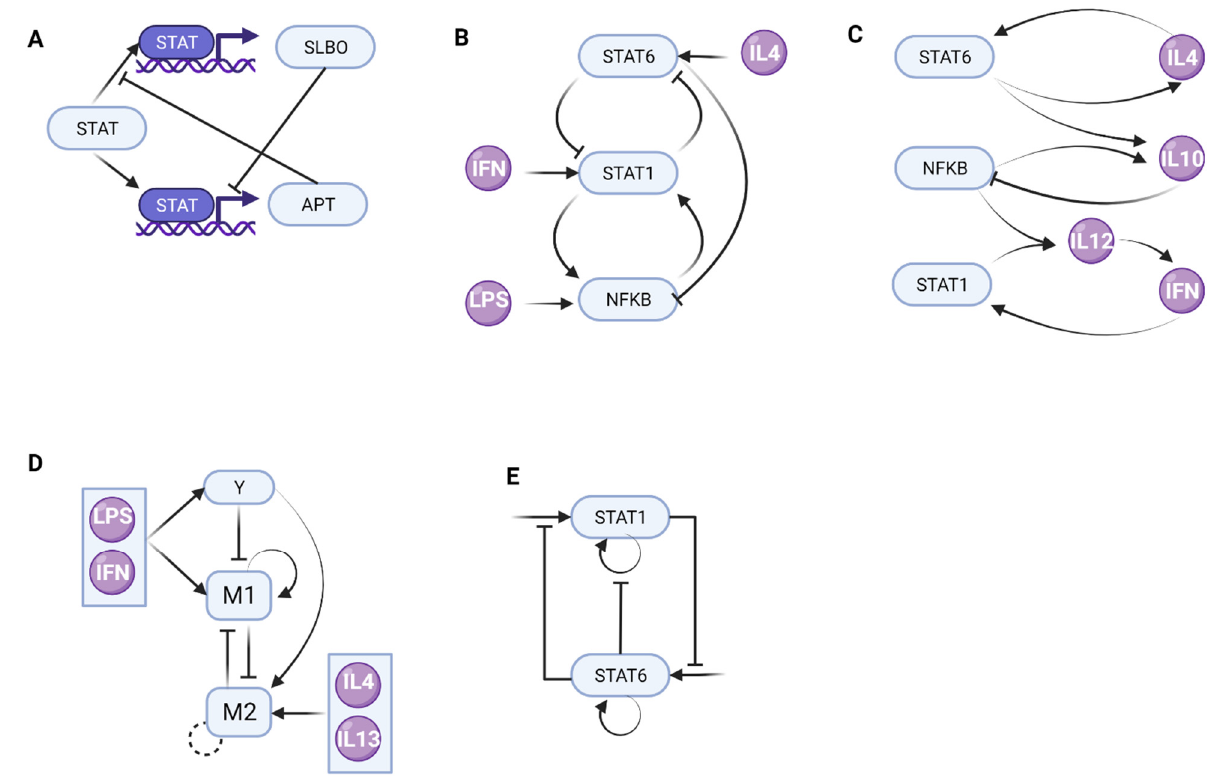
Figure 2. Models showing multistability of signaling pathways involved in macrophage transitions: ( A ) The inhibition of STAT activity by APT and the cross-repression of APT and SLBO conforms to a molecular switch that determines if an epithelial cell becomes motile or remains stationary. ( B ) The mutual inhibition and mutual activation of STAT6, STAT1, and NFKB creates saddle-node bifurcations in macrophage polarization. ( C ) An agent-based model describes macrophage population behavior in the context of cytokine production to influence bistability switches and demonstrates that a dynamic bifurcation is a crucial built-in mechanism of macrophage activation. ( D ) A minimal regulatory model shows that a mutual inhibition motif is not by itself sufficient; an incoherent feedforward mechanism of M1 activation as well as both inhibition and activation of M2 by M1 are required for bistability. Y represents feedback inhibition mechanisms. ( E ) A simple model of macrophage polarization tracking STAT1 and STAT6 activation levels as proxies for M1 and M2 transitions, including self-stimulation and a mutual-inhibition to demonstrate that both external cues and intrinsic pathways are equally important for the emergence of bistability. Figure created with BioRender.com (accessed on 22 December